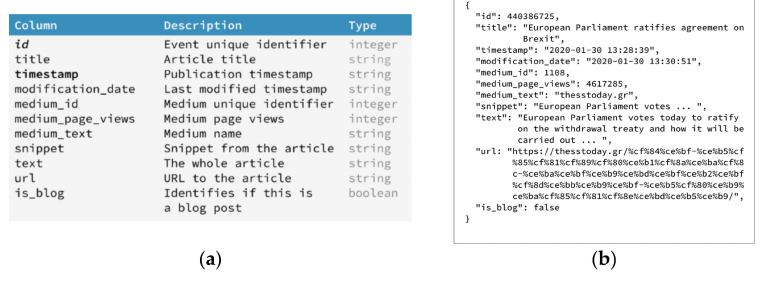
Figure 4. ( a ) Event schema; ( b ) example event